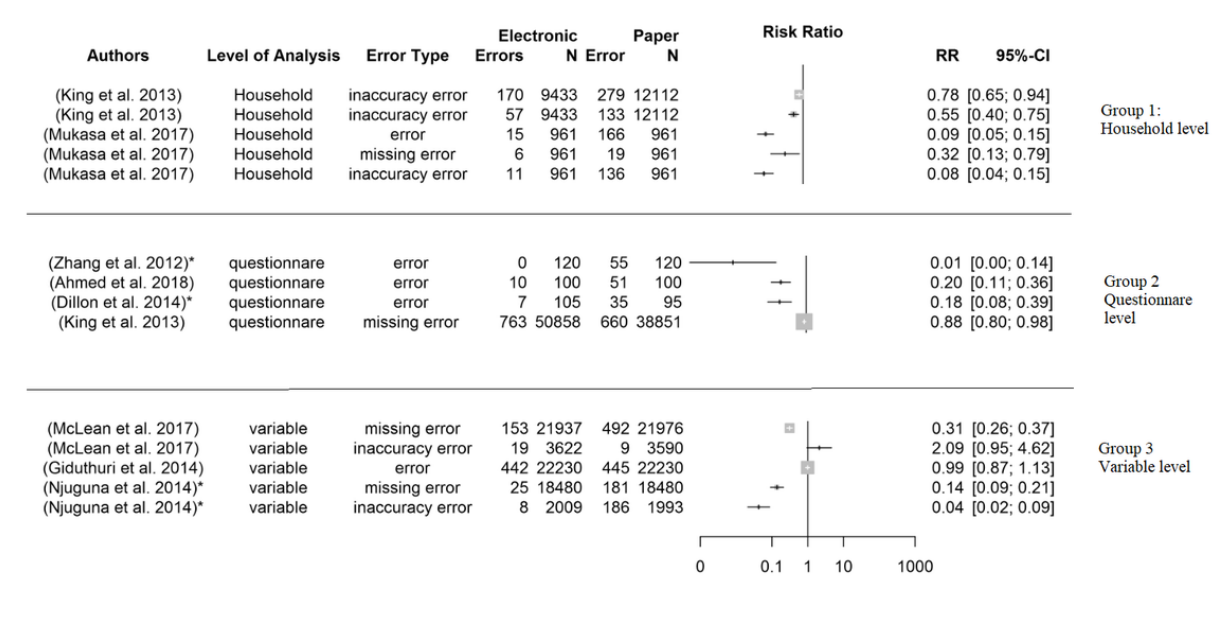
Figure 2. Forest plot comparison of heterogeneity characteristics of the data quality